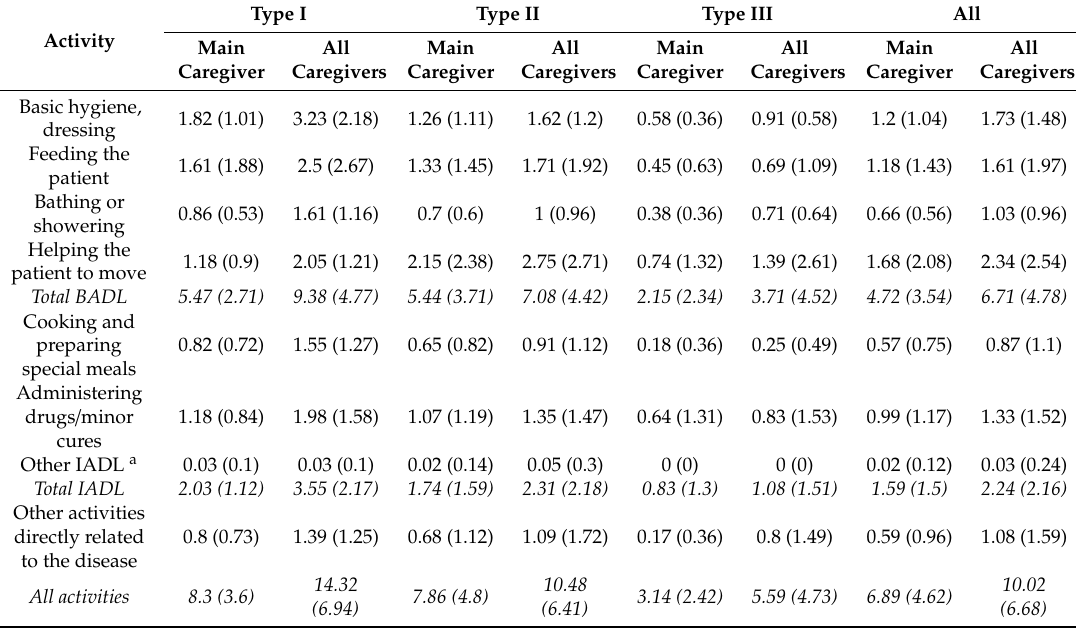
Table 2. Mean hours (SD) of informal caregiving provided daily to patients with SMA by type of SMA.